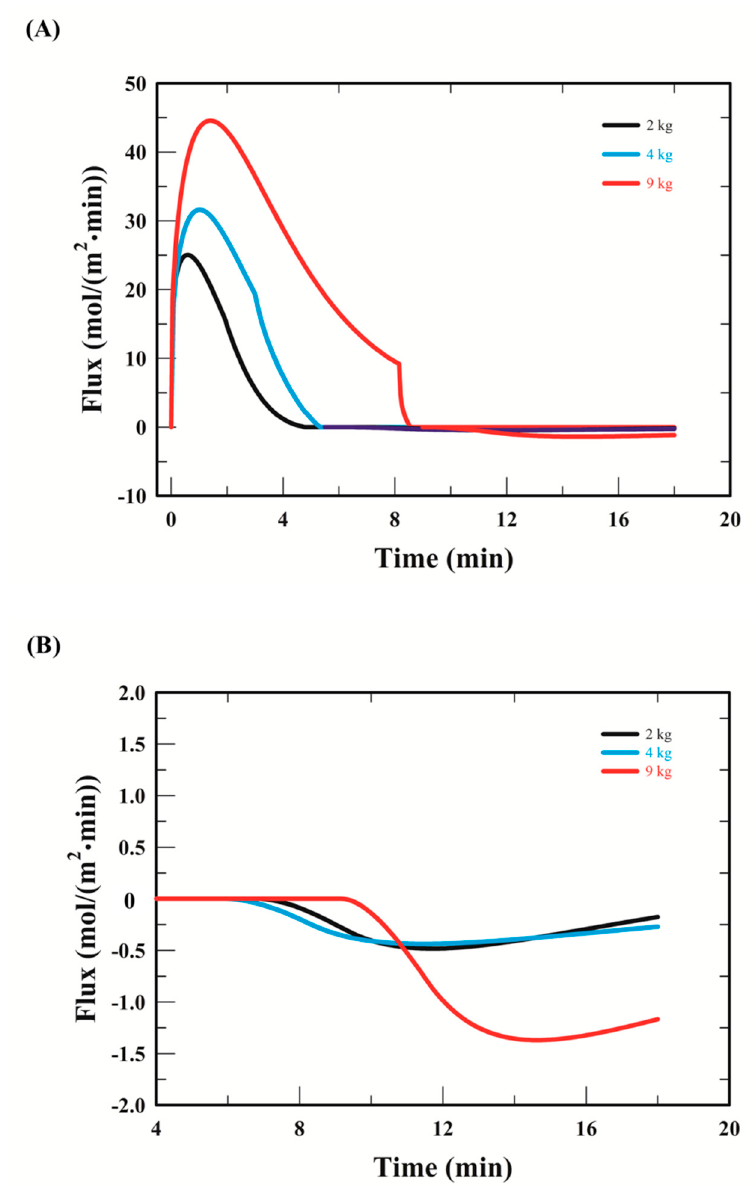
Figure 6. Simulated profiles of the mass flux on the WG surface in the heating stage ( A ) and cooling stage ( B ) during drying in the FBD with different WG loadings, from 2 to 9 kg, at 120 °C.